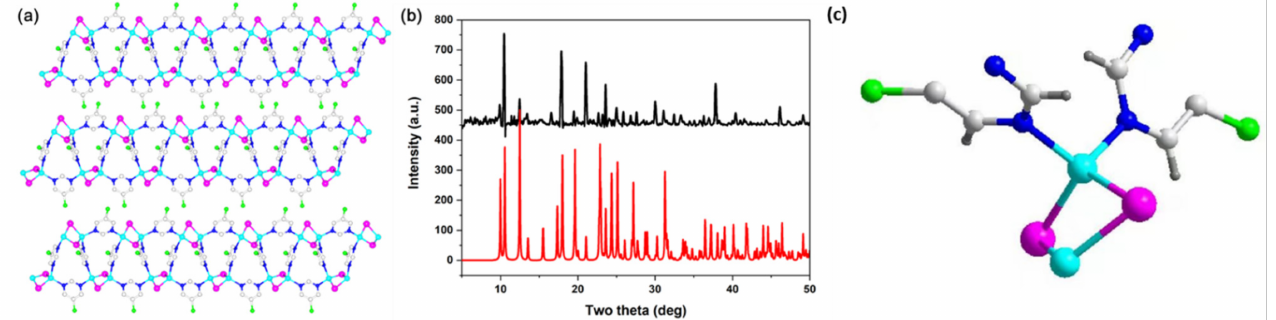
Figure 1. ( a ) Structural plot of compound 1 . ( b ) PXRD patterns of simulated 1 (red) and as made 1 (black). ( c ) Asymmetric unit of compound 1 . (Cyan: Cu atoms; pink: I atoms; grey: C atoms; blue: N atoms; green: Cl atoms; dark grey: H